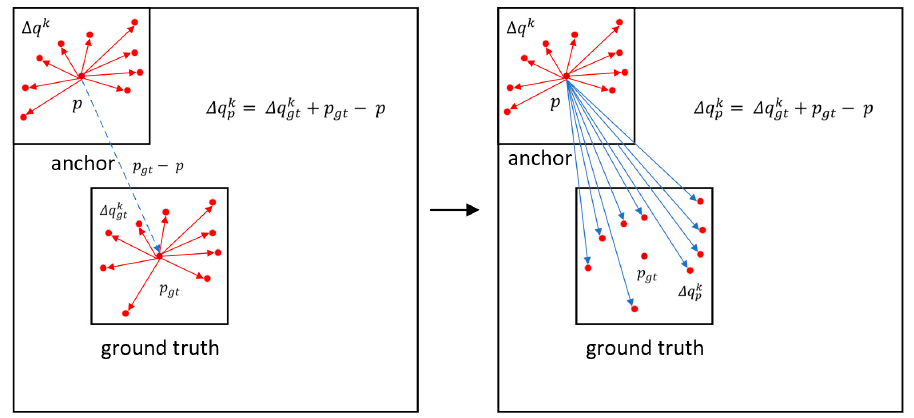
Figure 5. Illustration of the feature alignment. Δ𝑞 (cid:3038) is the predicted offset, Δ𝑞 (cid:3034)(cid:3047)(cid:3038) is the offset in the ground truth, and Δ𝑞 (cid:3043)(cid:3038) is the offset after feature alignment. 𝑝 and 𝑝 (cid:3034)(cid:3047) are anchor center point and ground truth center point, respectively.